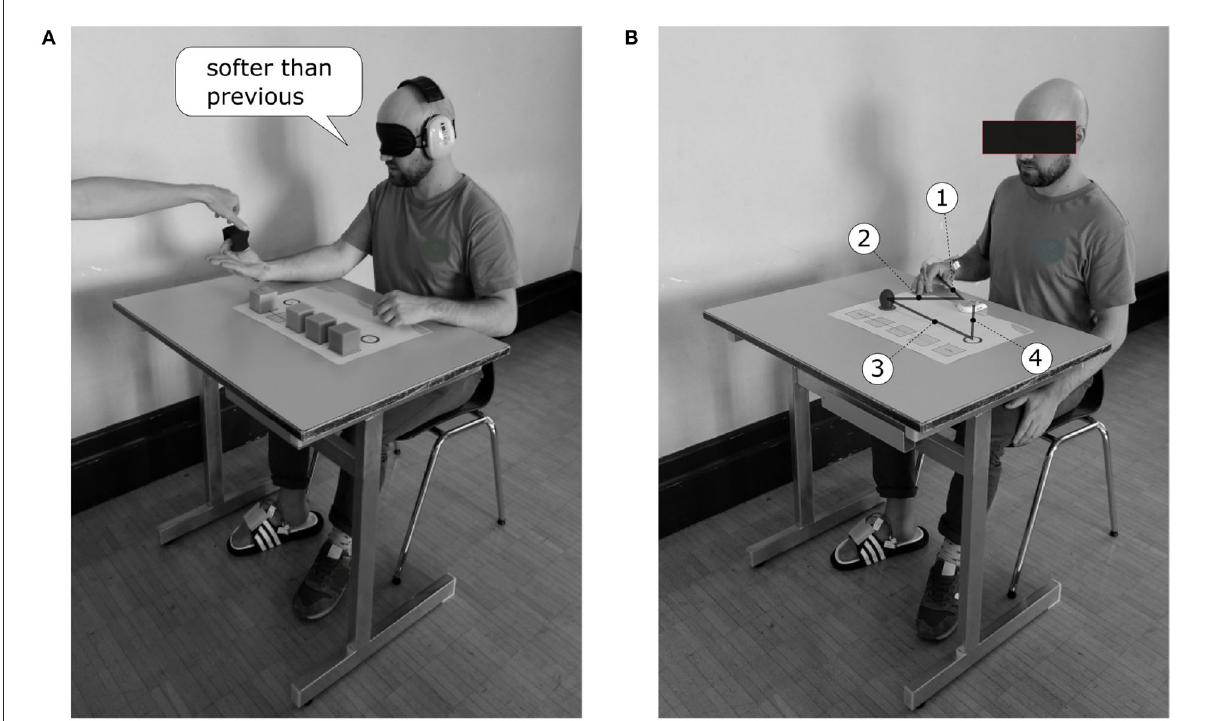
FIGURE2 Setup of the experiments. The FeetBack glove was donned on the cover of the prosthetic hand and the FeetBack insole was worn on the right foot. The participants remained seated throughout the tests. (A) In the object sorting task, the participants were blindfolded and were wearing ear muffs. They rested the arm with the prosthesis on the table with the open hand upward. The investigator put the objects between the index finger and thumb. The participants had to answer if the current object was harder or softer than the previous object. (B) In the pick and place tasks, the participants started in a resting position as shown. After an oral start signal by the investigator, the participants moved the hand from the starting position to the clock and started said clock with the prosthesis in step 1. In step 2, the participants moved the prosthesis from the clock to the object and pinched it. In step 3, they lifted the pinched object from the side of the prosthesis to the contra-lateral target and released the object. In step 4, they stopped the clock with the prosthesis.